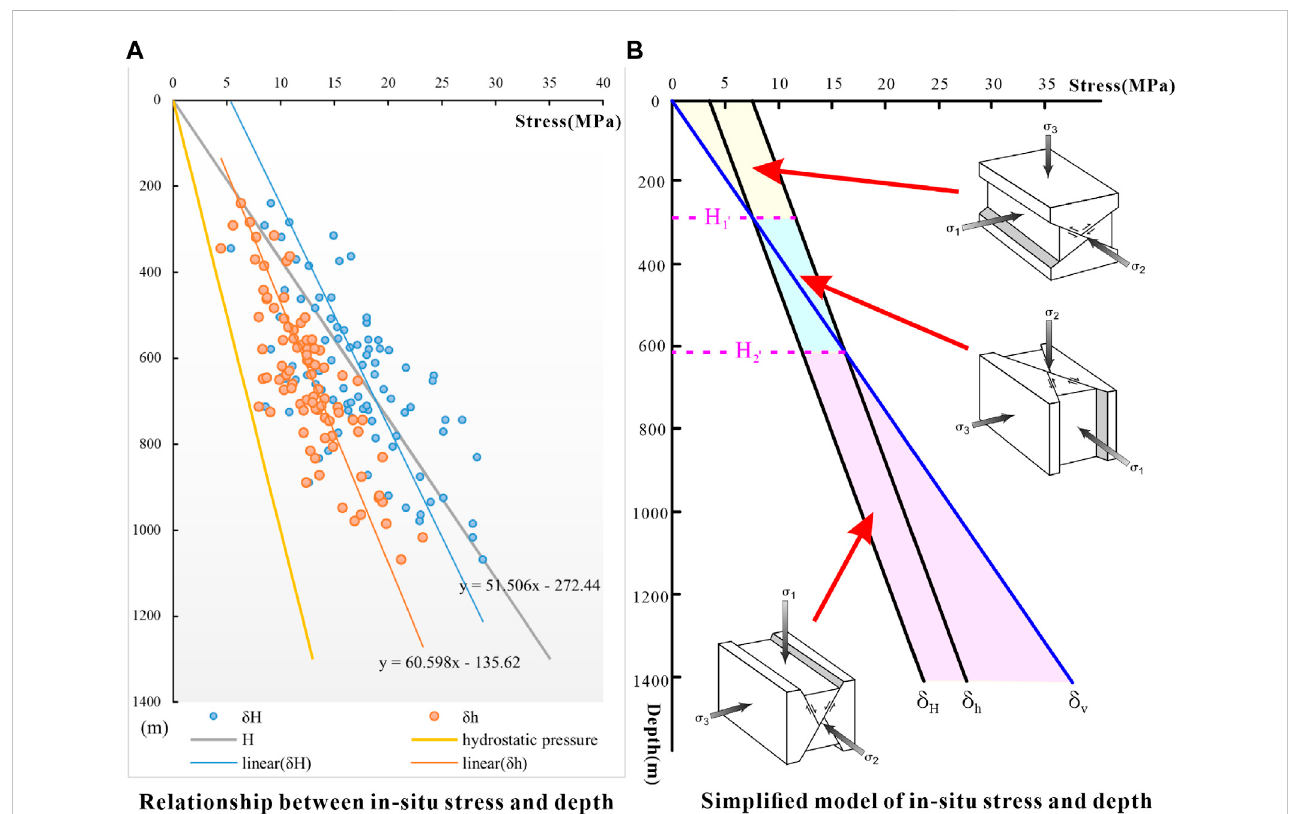
FIGURE 7 Relationship between triaxial in situ stress and depth in western